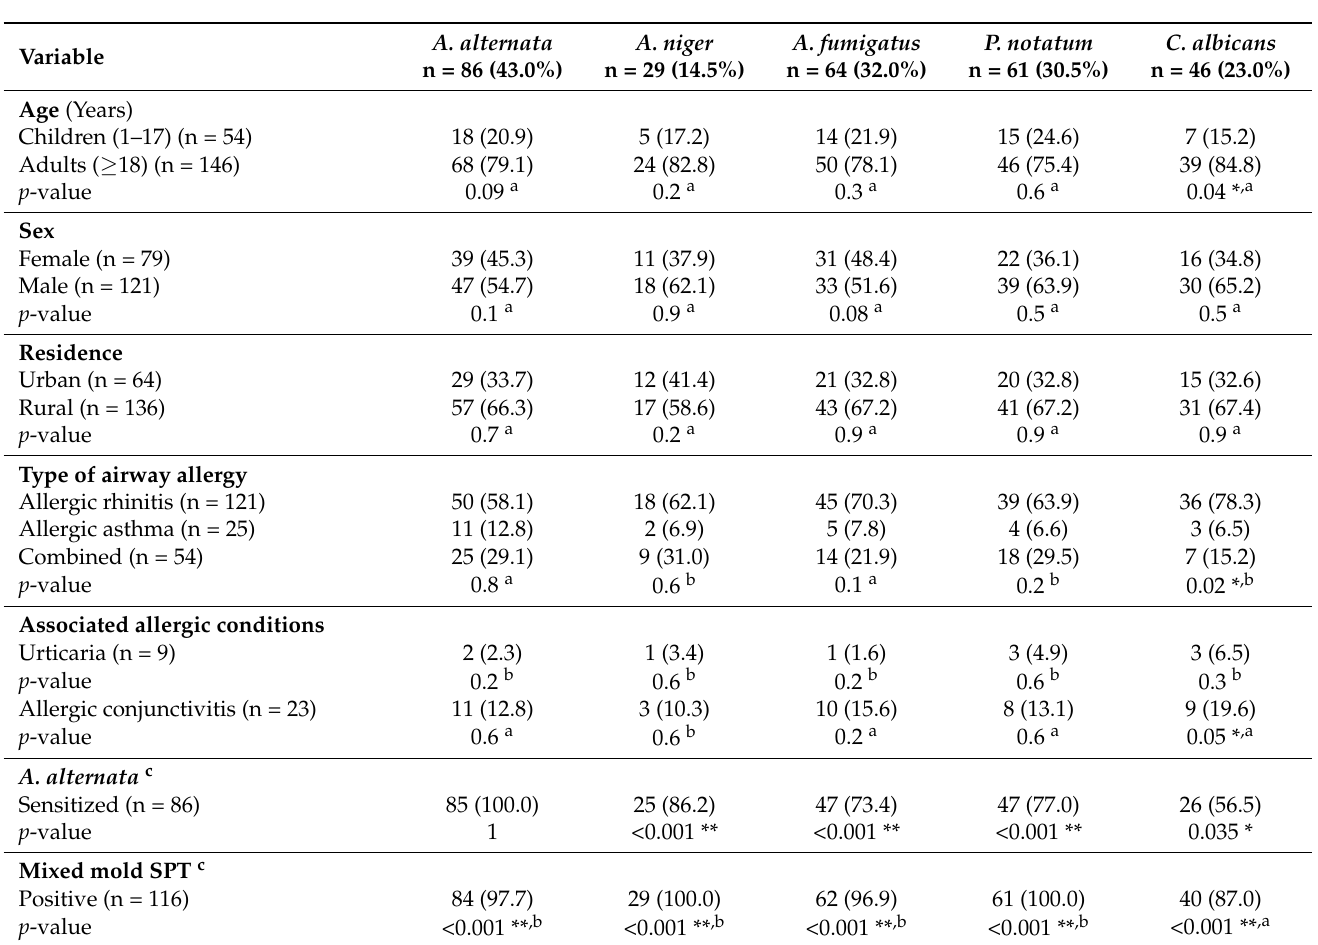
Table 3. Variables associated with patterns of fungal aeroallergen sensitization in studied patients (N =